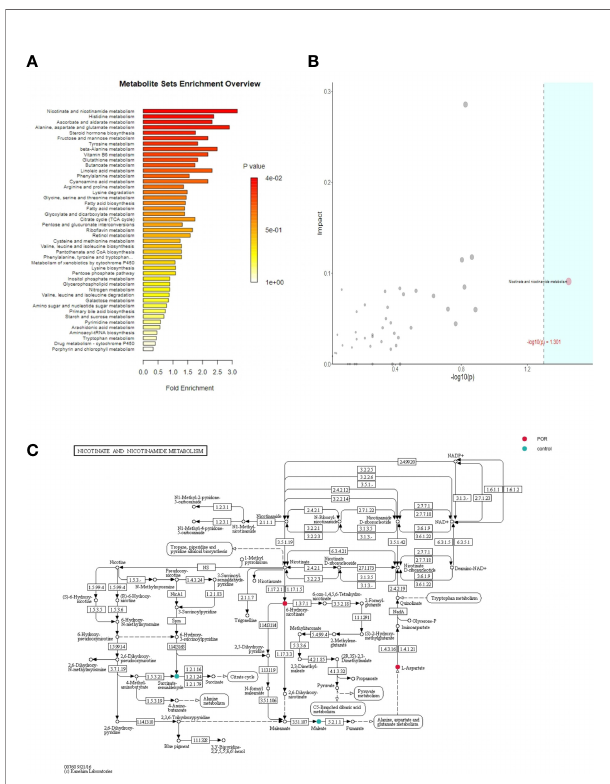
FIGURE 10 | Enrichment analysis of over-representation analysis (ORA) (A) , topoenrichment analysis (B) , and the metabolic pathway gene map (C) . (A) The abscissa is enrichment factor, which is the number of observed metabolites/ theoretical metabolites in metabolic pathway. The size of P value is expressed by color. The darker the color is, the smaller the p value is. (B) The abscissa is the p value of ORA analysis, and the blue area is signi fi cant (P < 0.05); The ordinate is the topological analysis impact. (C) Colored metabolites are metabolites with signi fi cant differences between groups. Color corresponds to the group, indicating that the content of metabolites in the corresponding group is higher (compared with the other